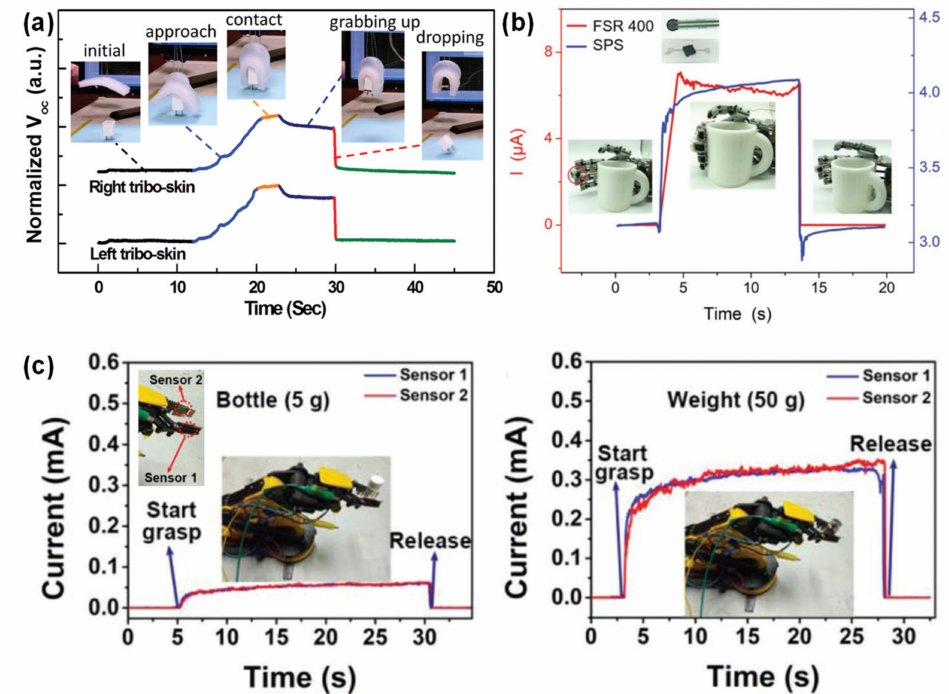
Figure 17. E-skins applied in robotics. ( a ) Output of the e-skin developed by Zhong Lin Wang and co-workers in 2018 for the grasping and dropping of an object by a soft gripper [40] (Copyright © 2020 WILEY-VCH Verlag GmbH & Co. KGaA, Weinheim, Germany). ( b ) Output of the e-skin developed by Zhengchun Peng and co-workers in 2019, worn in a humanoid robotic hand, for the grasping and dropping of an object (SPS), compared to the performance of a commercial sensor (FSR 400) [144] (Copyright © 2020 WILEY-VCH Verlag GmbH & Co. KGaA, Weinheim, Germany). ( c ) Output of the e-skin developed by Vellaisamy Roy in 2019, attached to a robotic arm, when grasping and releasing objects with di ff erent weights [170] (Copyright © 2020 WILEY-VCH Verlag GmbH & Co. KGaA, Weinheim,